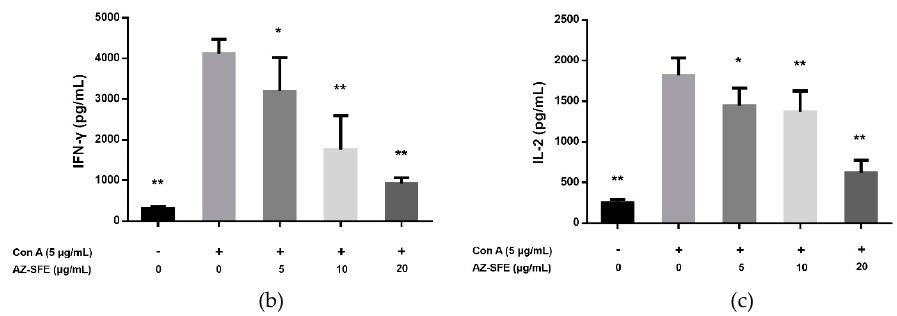
Figure 4. Effects of AZ-SFE (5, 10 and 20 μ g/mL) on splenocyte proliferation and cytokine production. Cells treated without Con A and AZ-SFE were the blank control group, and cells incubated only with Con A were the Con A group. ( a ) Cell viability was detected by MTT assay, ( b ) IFN- γ and ( c ) IL-2 in supernatants were measured by ELISA. Data are presented as mean ± SD ( n = 6). * p < 0.05, ** p < 0.01 versus Con A group.